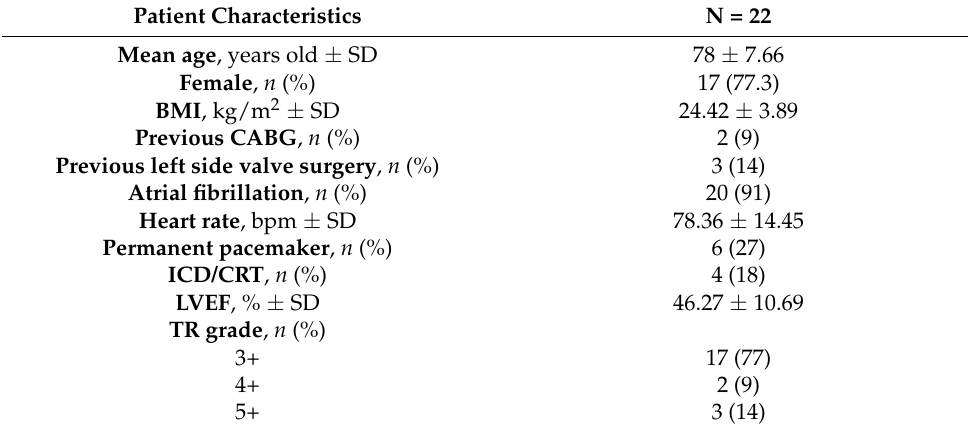
Table 1. Baseline clinical characteristics.